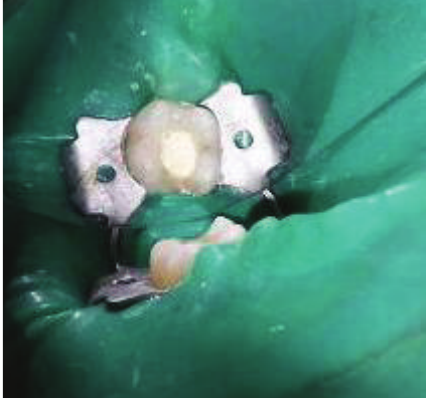
Figure 36: Placement of Biodentine over the PRF membrane 36.